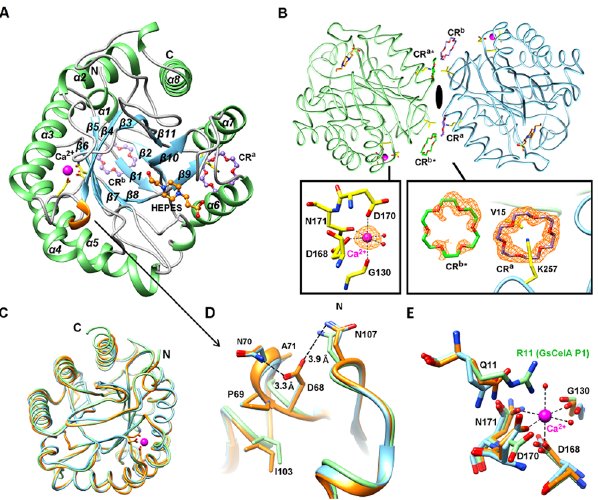
Fig 5. Crystal structure of chimera C10/crown ether complex. (A) The overall structure of C10 with HEPES, two CR molecules, and a calcium ion (ball-and-stick models). (B) Two C10 monomers (light green and light blue) from different unit cells are in contact with 2-fold symmetry. Two CR molecules interacting across different unit cells, CR a and CR b+ , are shown as purple and green carbon atoms, respectively. Fo-Fc omit maps (orange) were calculated for the Ca 2+ and CR molecules at 2 σ level. The calcium ion is bound to two water molecules, the backbone oxygen of G130 and the three carboxylate side chains of D168, D170 and N171, with an octahedral configuration. A CR molecule (CR a ) is bound to K257 and V15 from two different C10 monomers. The second CR molecule (CR b ) has a hydrophobic interaction with CR a . (C) Comparison of GsCelA P1, BsCe5lA P2 (PDB: 3PZT) and chimera C10 structures. The catalytic domains are superimposed and colored in green, blue and orange, respectively. The N and C termini are also indicated. (D) β 4 α 3 loop region comparison. GsCelA P1, BsCe5lA P2 and chimera C10 are colored as before. The D68 side chain atoms are hydrogen bonded to N70 and N107, while P69 has a hydrophobic interaction with I103. The chimera C10 protein residues are shown as stick models and carbon atoms are colored orange. (E) The Ca 2+ binding sites in GsCelA P1, BsCe5lA P2 and chimera C10 are superimposed. The carbon atoms of GsCelA P1, BsCe5lA P2 and chimera C10 are colored in light green, light blue and orange, respectively. The Ca 2+ atom from GsCelA P1 is depicted as a light magenta sphere.